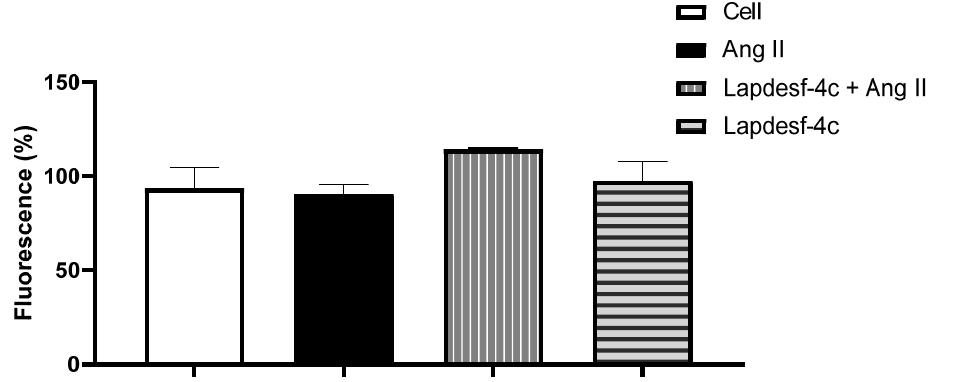
Figure 6. Percentage of fluorescence using DAF-2DA as probe after incubation of HUVEC cells with Ang II, Lapdesf-4c, and combined treatment ( Lapdesf-4c + Ang II) without differences.